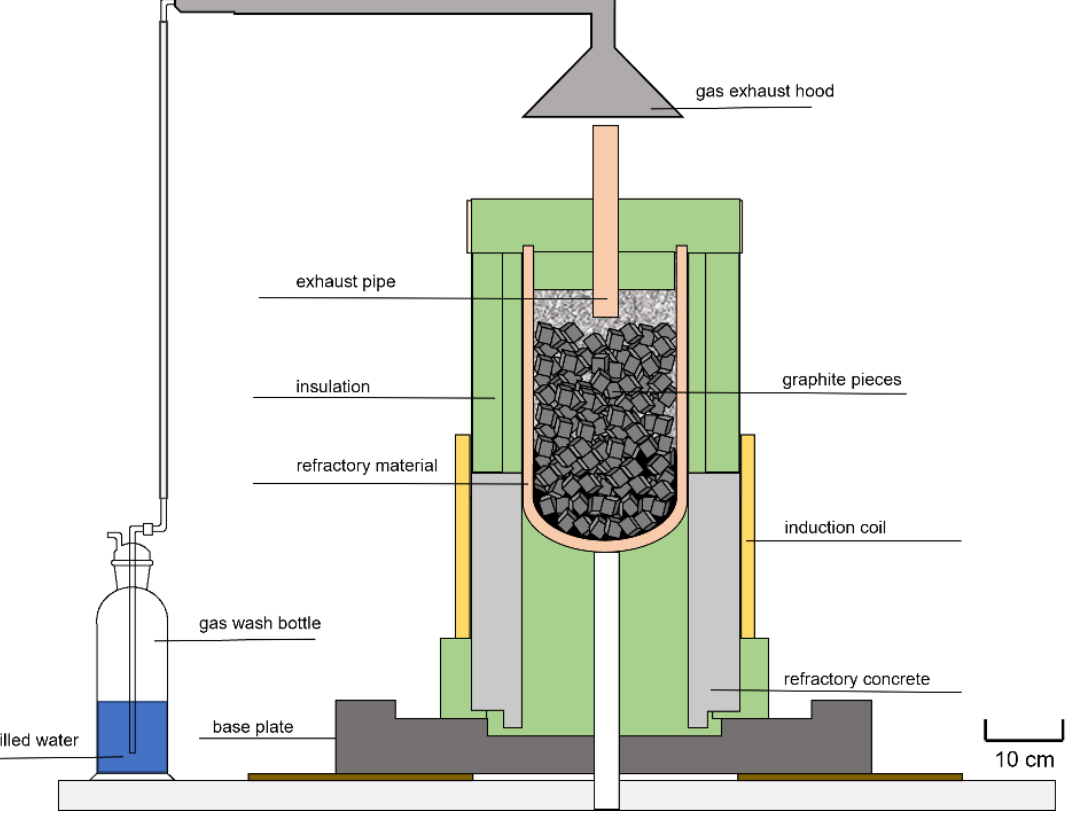
Figure 4. Schematic illustration of the InduMelt plant [38].